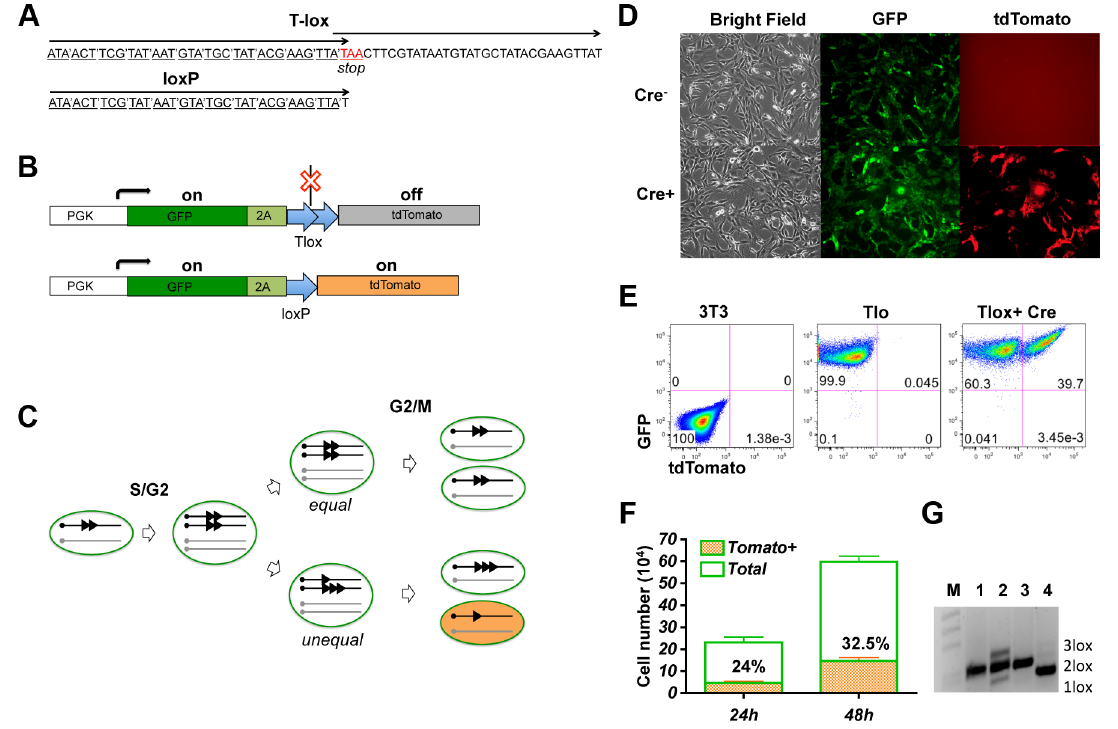
Figure 1. Genetic labeling of proliferating cells invitro with the Tlox design. (A) A comparison between the Tlox and a single loxP sequences. Codons of the reading frame are marked in the Tlox sequence. The stop codon (in red) is in the overlapping region between the first and the second loxP sequences in Tlox. (B) Schematic of Tlox on MSCV retroviral backbone. In the presence of Tlox, both GFP and tdTomato are transcribed, but only GFP (indicated by the green color) is translated. When Tlox is replaced with a single loxP, both GFP and tdTomato (indicated by the orange color) are expressed. 2A is included as a target sequence for auto cleavage [34] to separate GFP and tdTomato. (C) Diagram illustrates Cre- mediated sister chromatid recombination via the Tlox site during mitosis. Results of both equal and unequal exchanges after the G2/M phase are shown. Unequal exchange (bottom part) produces daughter chromosomes carrying either single or triple loxP site. (D–E) 3T3 cells harboring the reporter construct were transduced with control empty virus or Cre virus and analyzed by fluorescent imaging (D) or FACS (E) 48 hours post viral transduction. (F) Cell counts of total and tdTomato positive cells at 24 or 48 hours post viral transduction. Non-transduced cells were excluded based on lack of hCD2 expression. Percentages of tdTomato positive cells are indicated in the plot. (G) PCR assay of genomic DNA with primers flanking the Tlox site. M, 1 kb-DNA size ladder; 1, reporter plasmid control; 2, total cells at 48 hours after Cre transduction; 3, parental cells before Cre transduction; and 4, FACS sorted double positive cells at 48 hours after transduction. Bands representing 1loxP, 2loxP, and 3loxP were verified by sequencing analysis after subcloning the PCR products into Topo vectors.